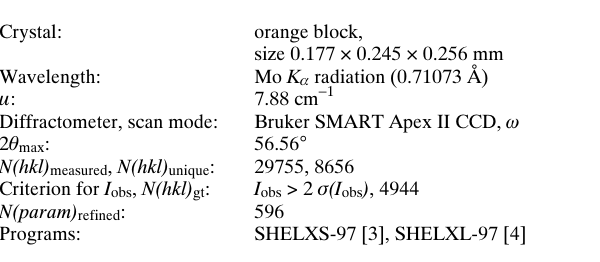
Table 1. Data collection and